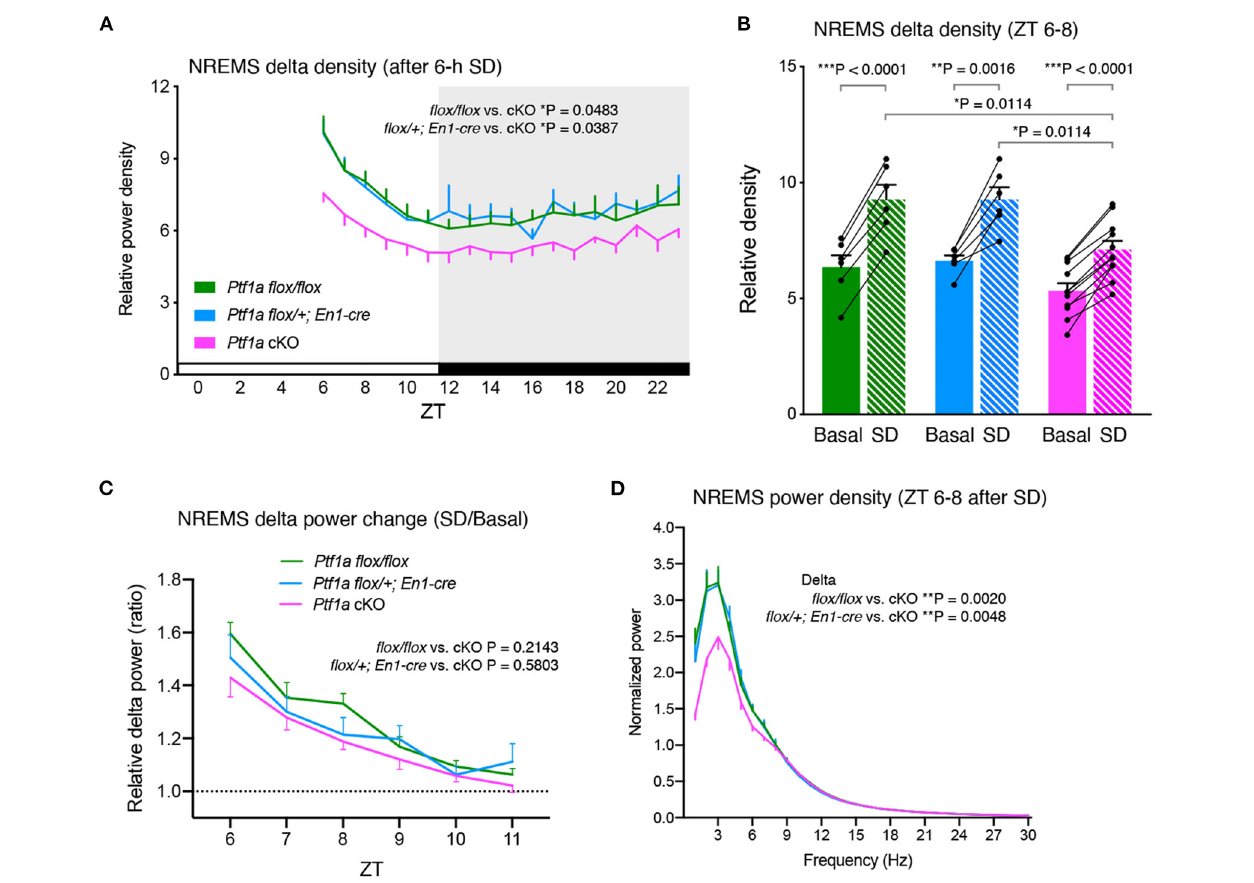
FIGURE 3 | Sleep/wakefulness of adult male Ptf1a cKO mice after 6h of sleep deprivation (SD). (A) Hourly NREMS delta power density of Ptf1a flox / flox ( n = 7), En1 cre / + ; Ptf1a flox / + ( n = 6), and En1 cre / + ; Ptf1a flox / flox ( n = 11) after 6h of sleep deprivation. Mixed-effects analysis followed by Tukey’s test. (B) NREMS delta density during ZT6–ZT8 of Ptf1a flox / flox ( n = 6), En1 cre / + ; Ptf1a flox / + ( n = 6), and En1 cre / + ; Ptf1a flox / flox ( n = 11) in the basal recordings and after 6h of sleep